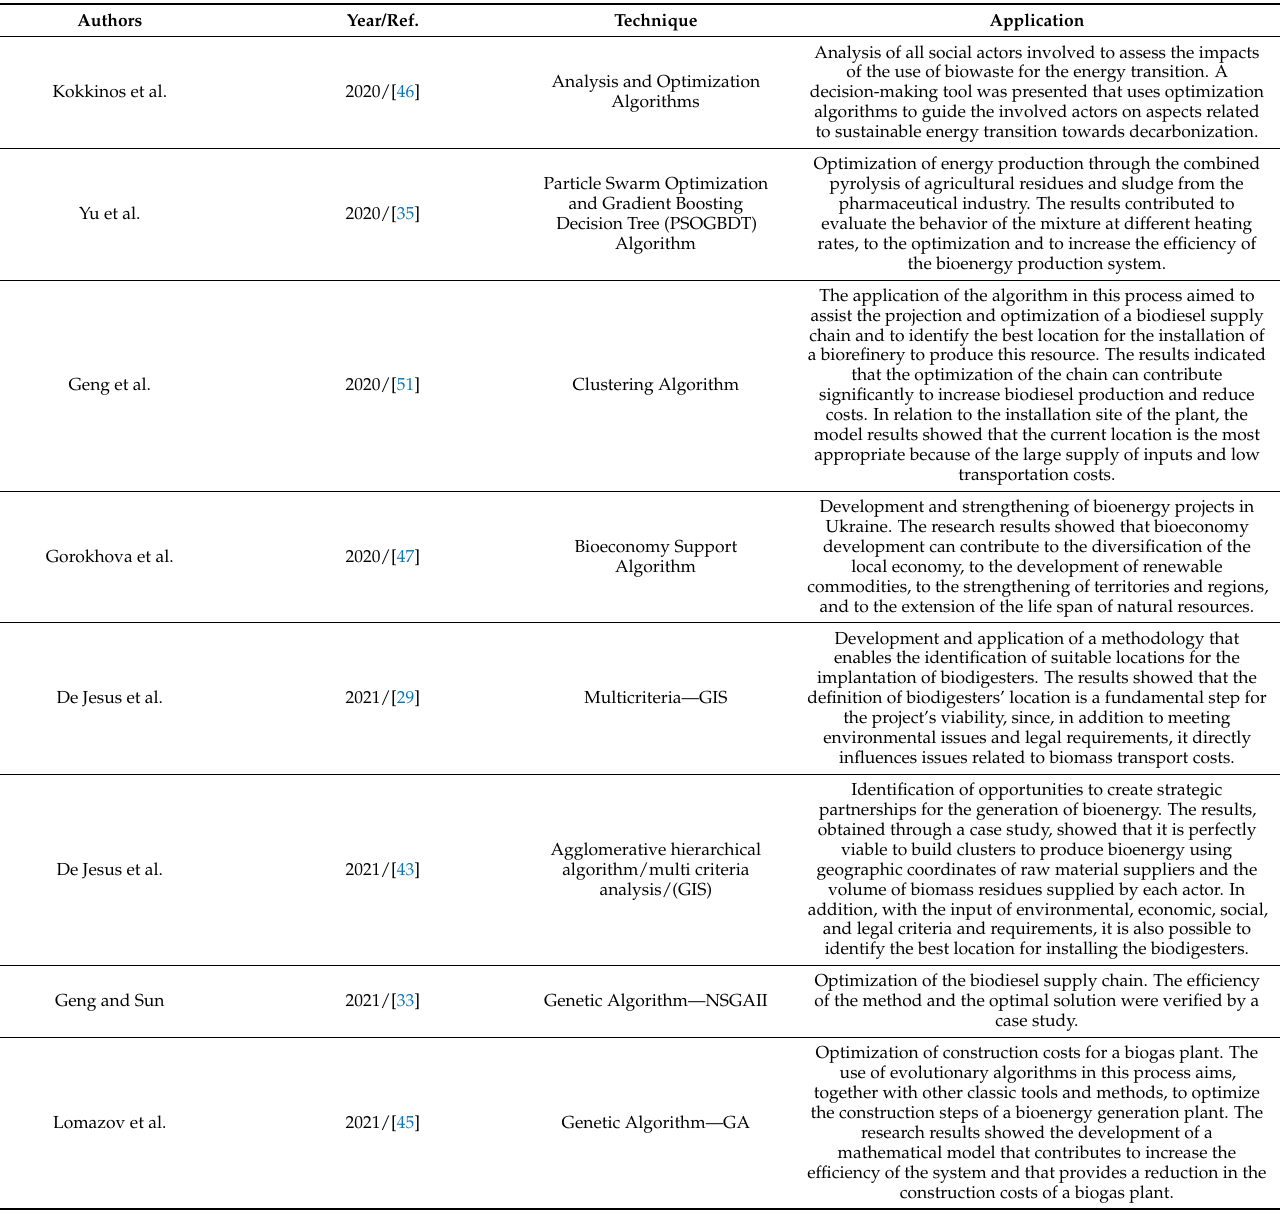
Table A4. Algorithm models identified in the analysis portfolio as well as their applications and expected results from 2020 and